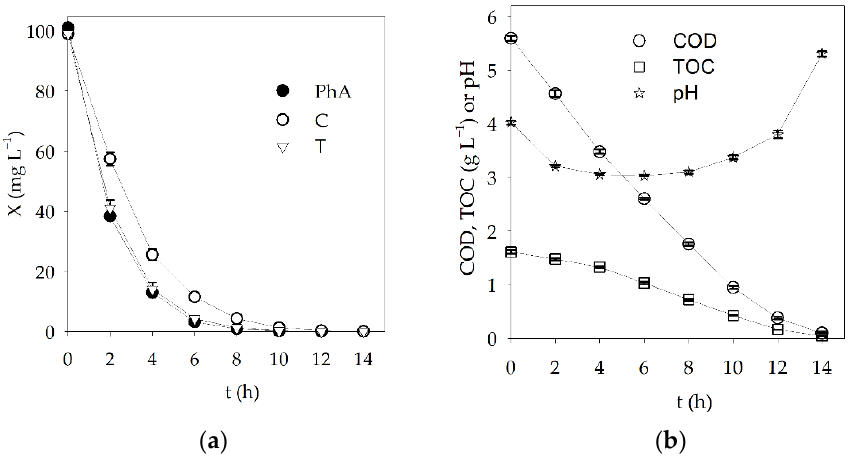
Figure 6. Variation with time of ( a ) PhA, T and C; and ( b ) COD, TOC, and pH for EO experiments performed with spiked winery wastewater at 300 A m − 2 for 14 h. Table 3. Characterization of winery wastewater treated by EO, at 300 A m − 2 for 14 h, and energy consumption attained by the